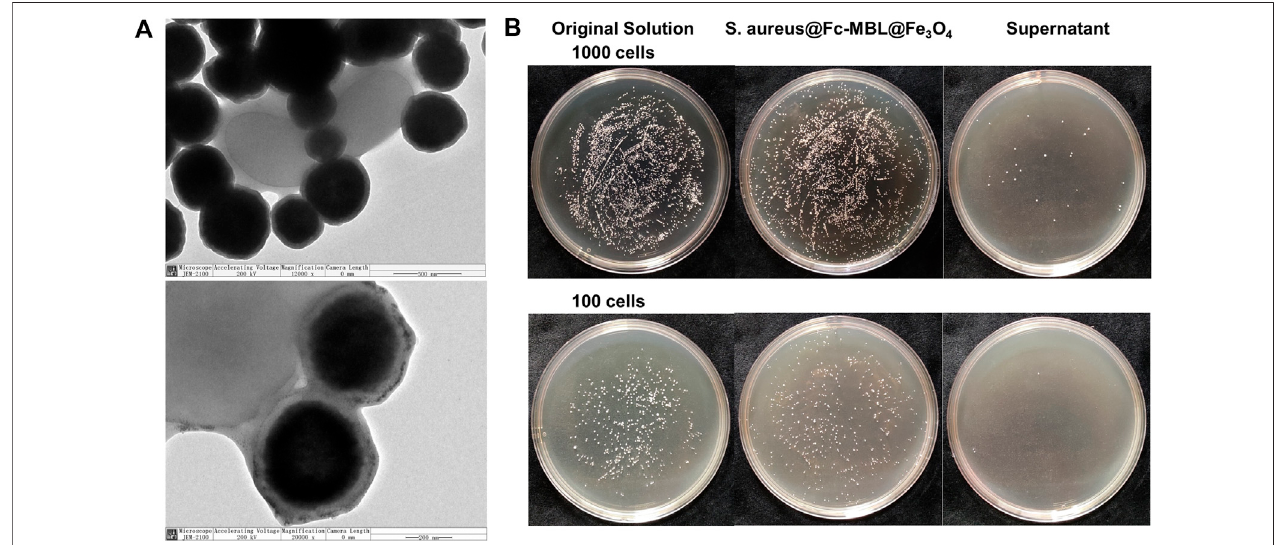
FIGURE1|(A) TEMimagesof S.aureus conjugatedwithFc-MBL@Fe 3 O 4 . (B)